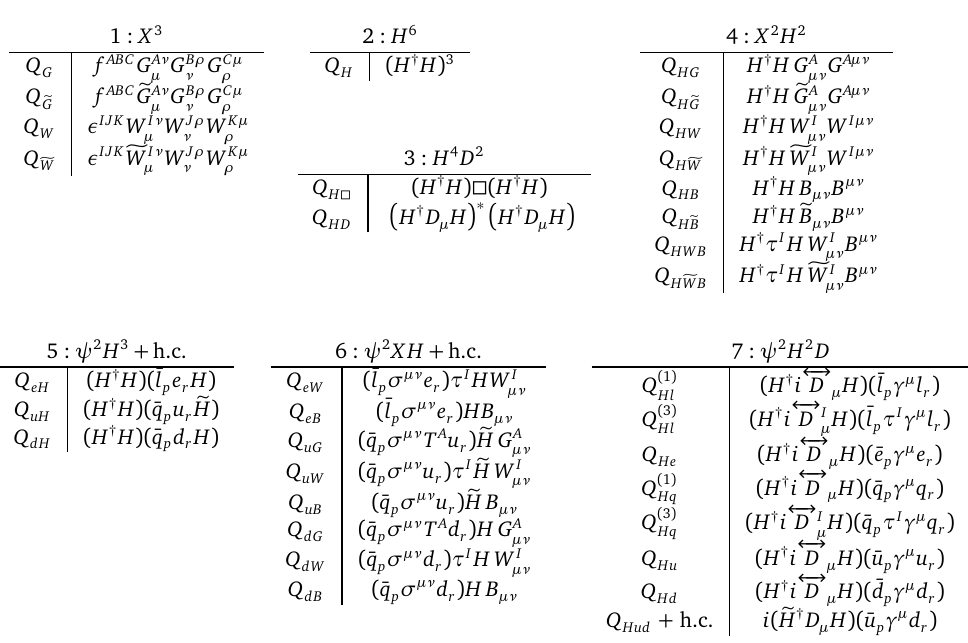
Table 1: The independent dimension-six operators built from Standard Model fields which conserve baryon number, as given in Ref. [ 2 ] . Four-fermion operators have been removed as they aren’t relevant to this analysis. The operators are divided into seven classes: X 3 , H 6 , etc. Operators with + h.c. in the table heading also have hermitian conjugates, as does the ψ 2 H 2 D operator Q . The subscripts p , r are Hud flavor indices. Table taken from Ref. [ 42 ]